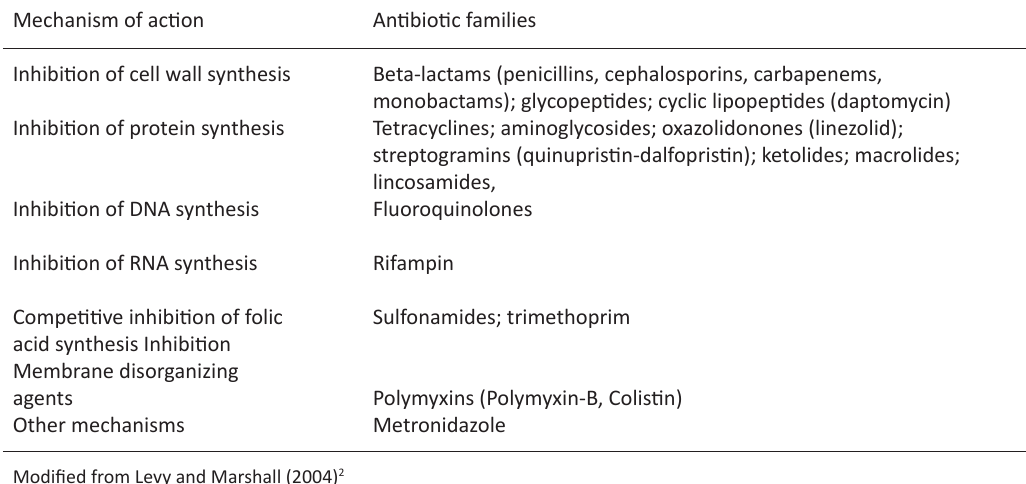
Table1. Major antibiotic classes by mechanism of action Mechanism of